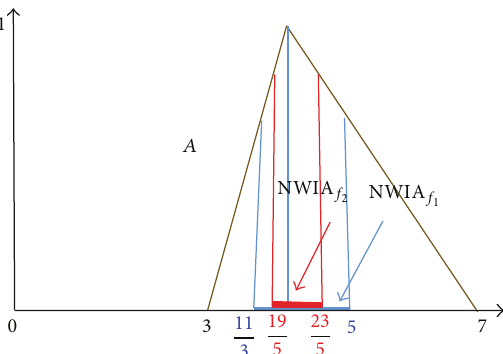
Figure 2: Triangular FN and its interval